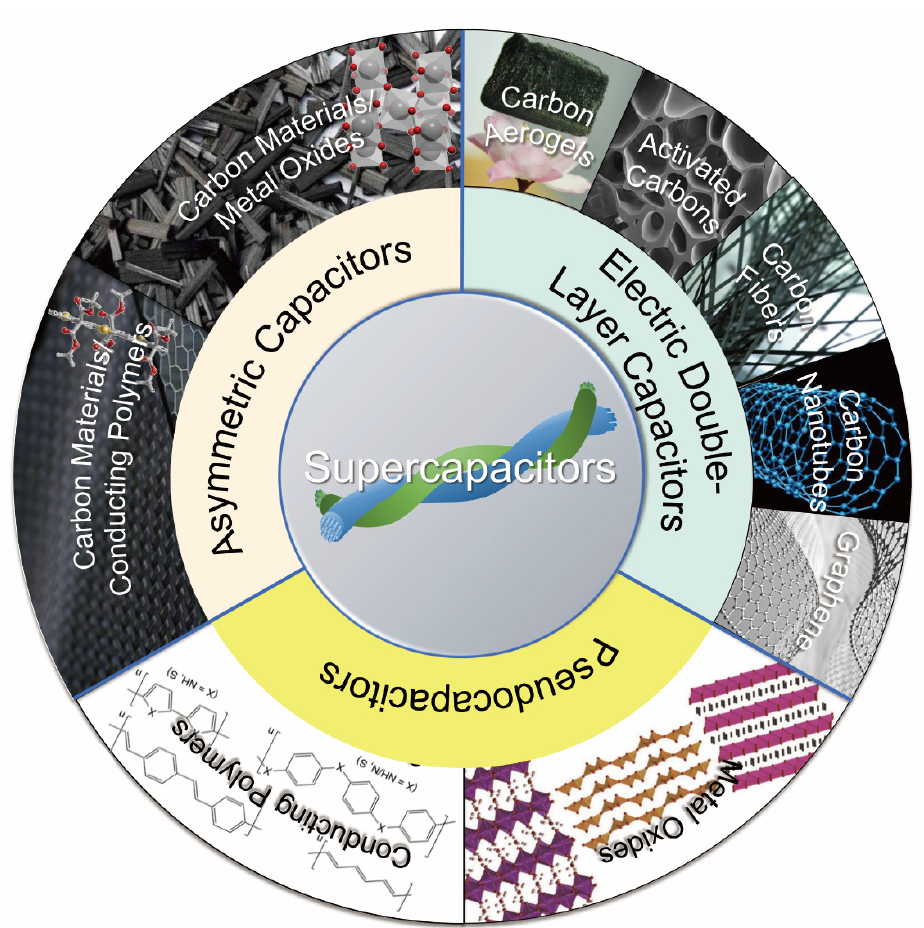
Figure 7. The diagram illustrating typical electrode materials for different types of